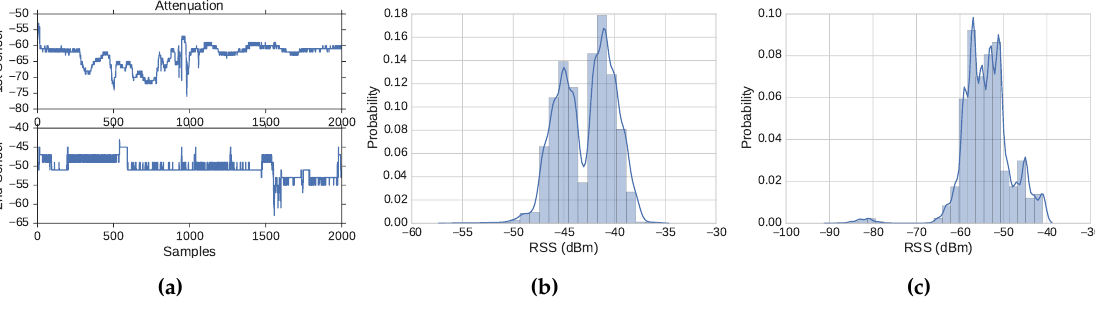
Figure 4. Data distribution and attenuation. ( a ) Attenuation; ( b ) Location 8: Sensor 1 data distribution; ( c ) Location 8: Sensor 2 data